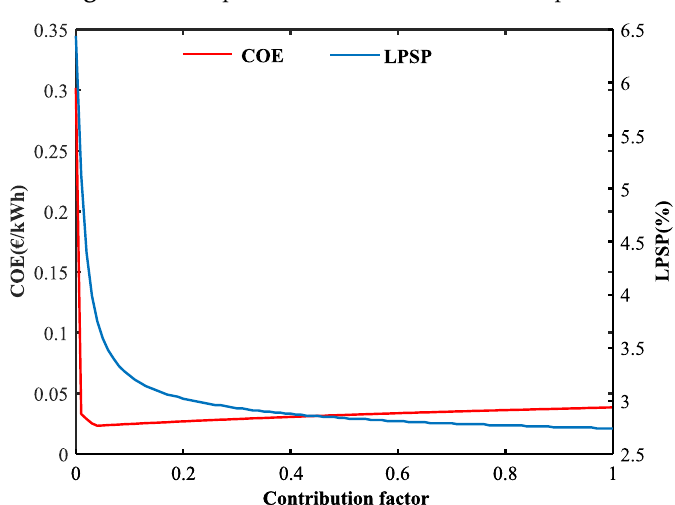
Figure 14. COE and LPSP for different contribution